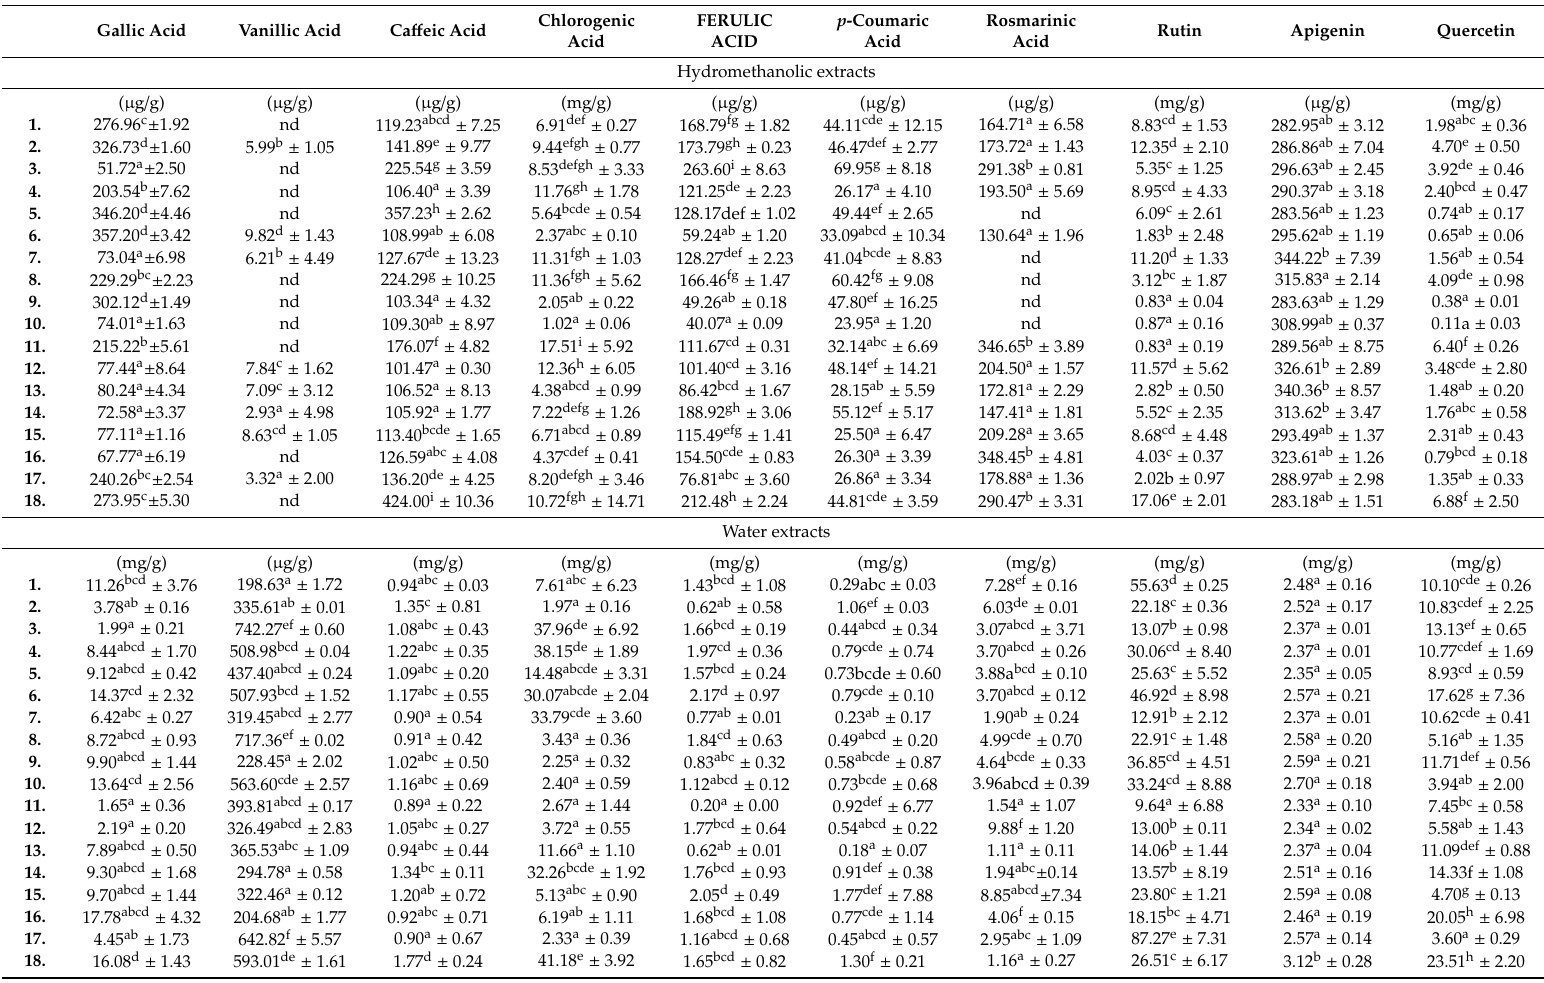
Table 3. Phenolic compounds in Morus alba L. samples (arithmetic mean ± standard